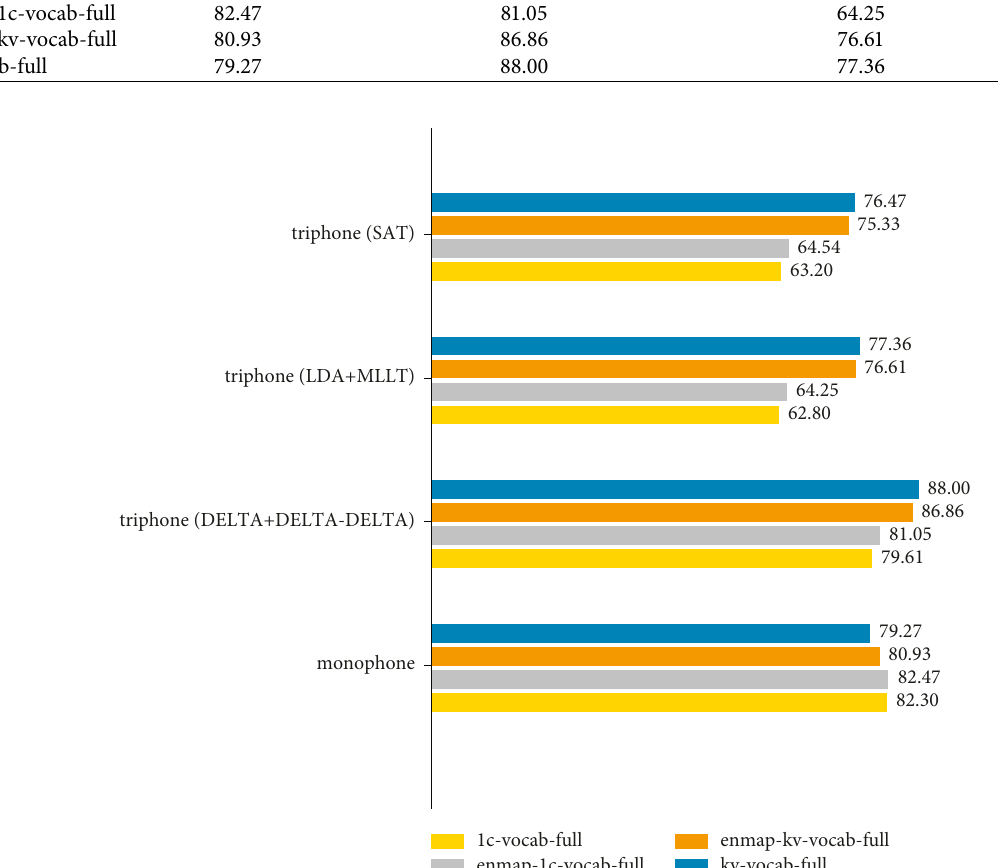
Figure 6: The %WER of the GMM-HMM models trained using 10,000 validated utterances. Table 9: The performance of the acoustic models using 10,000 unvalidated utterances. Lexicon